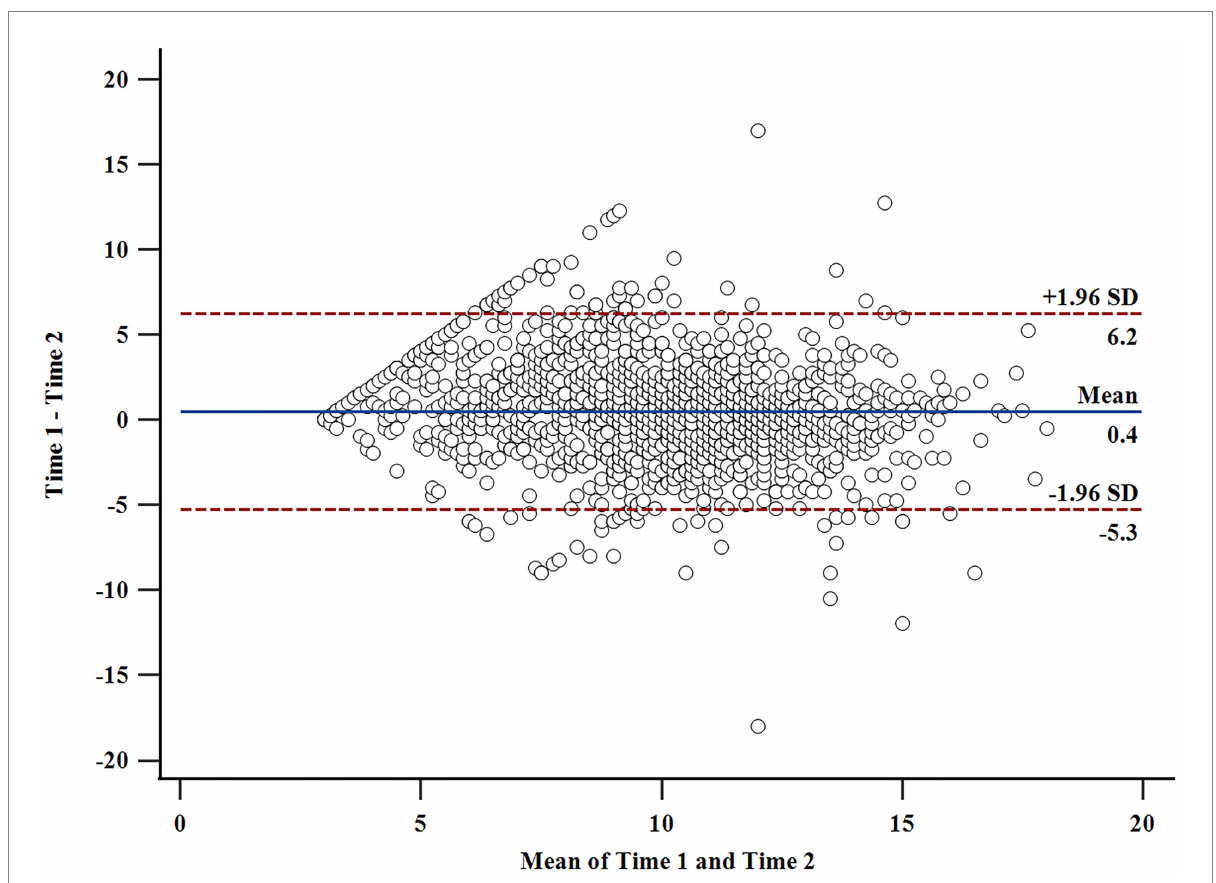
FIGURE 2 Bland–Altman plot of the Psychological Need Thwarting Scale of Online Teaching (PNTSOT) from Time 1 and Time 2 ( n =